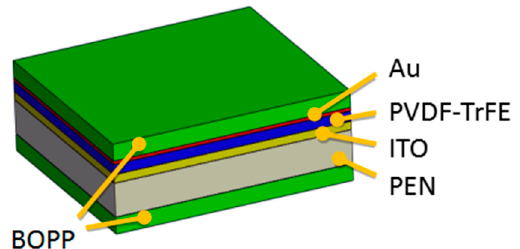
Figure 4. Cross-sectional structure diagram of PVDF-TrFE/nano-ZnO film sensor.